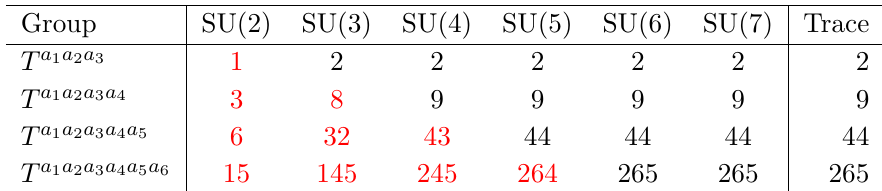
as shown by the f < N